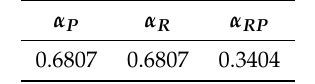
Table 1. Parameters of the primacy and recency effect, forgetting curve and